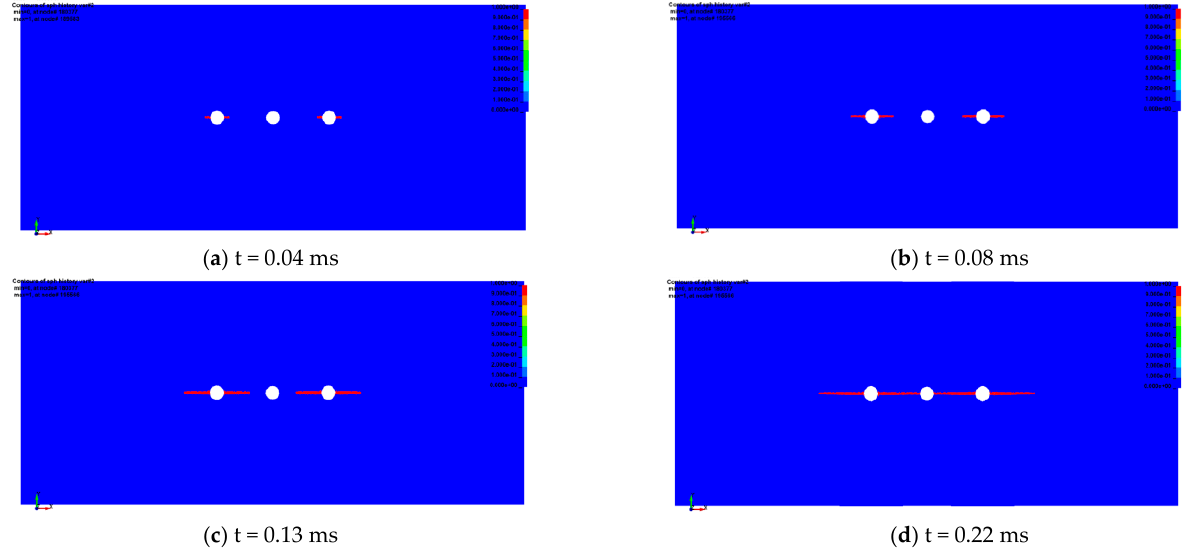
Figure 29. Development process of cracks caused by spaced-hole blasting with 200 mm spacing.